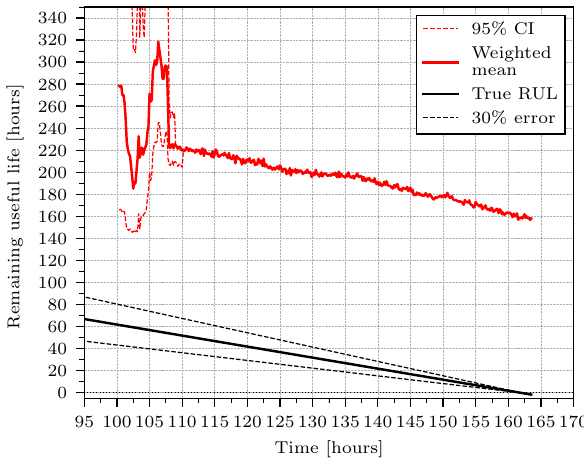
Figure 12: Estimated RUL of the IMS dataset using PF on RMS. The weighted mean, 95% CI, true RUL and 30% error margins are